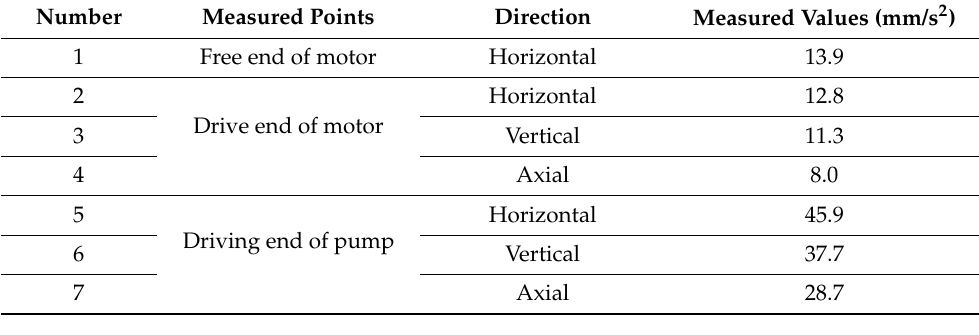
Figure 9. The actual faulty component of the engineering bearing. Table 3. The collected vibration values of the monitored machine. Figure 8. The monitored engineering object.